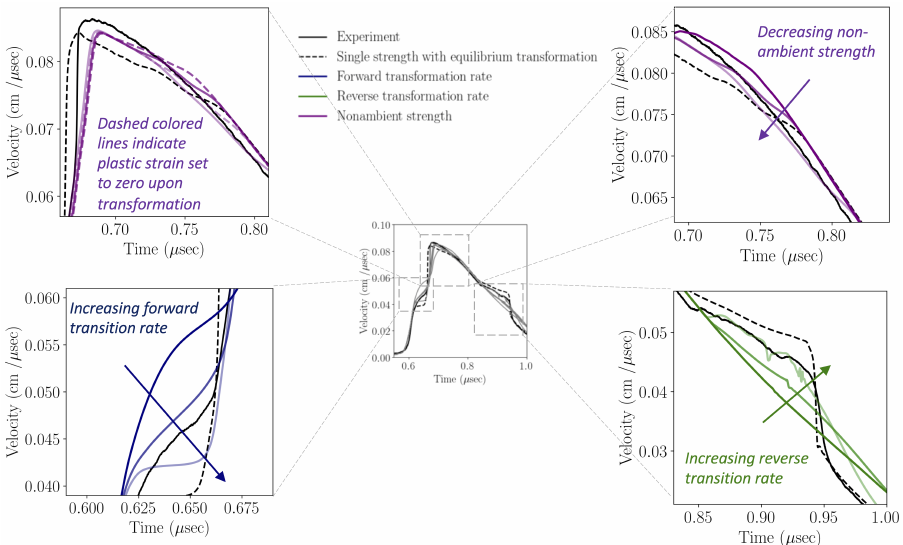
Figure 1. Sensitivity study results based on simulations of a dynamic ramp-release experiment as in